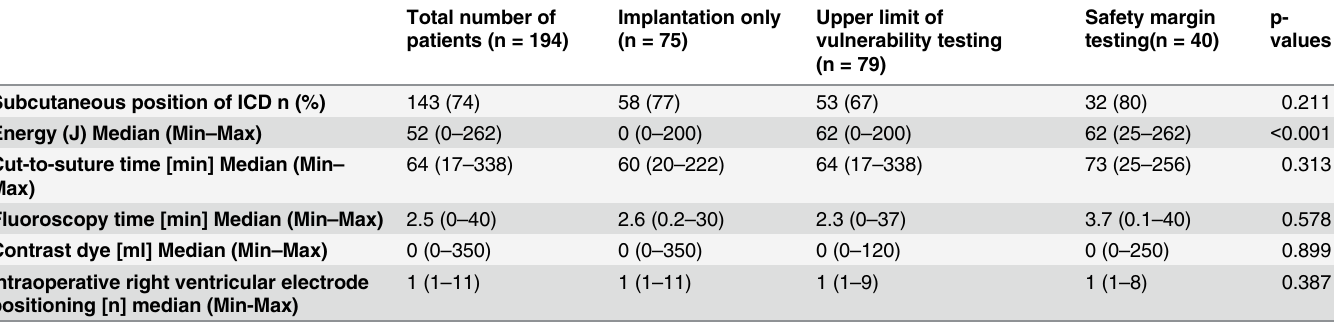
Table 3. Procedural